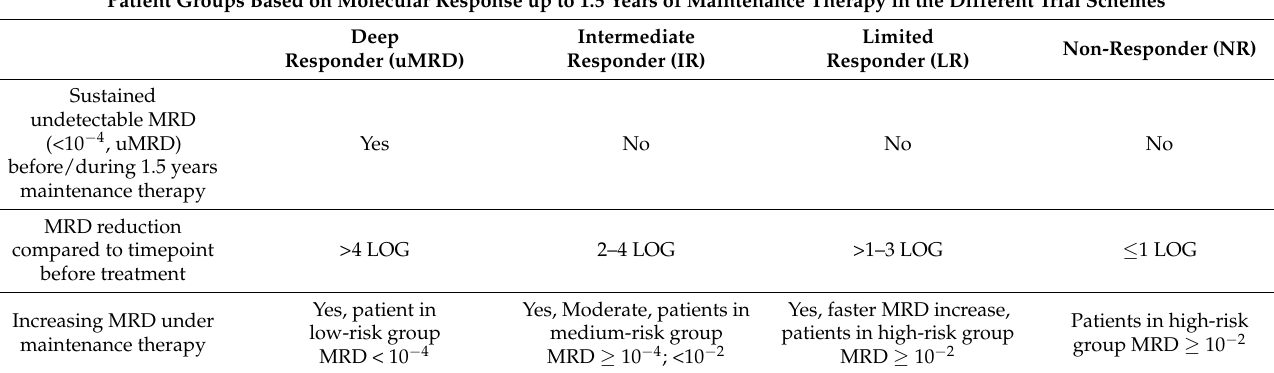
Table 1. Criteria for MRD response scoring to study CD20